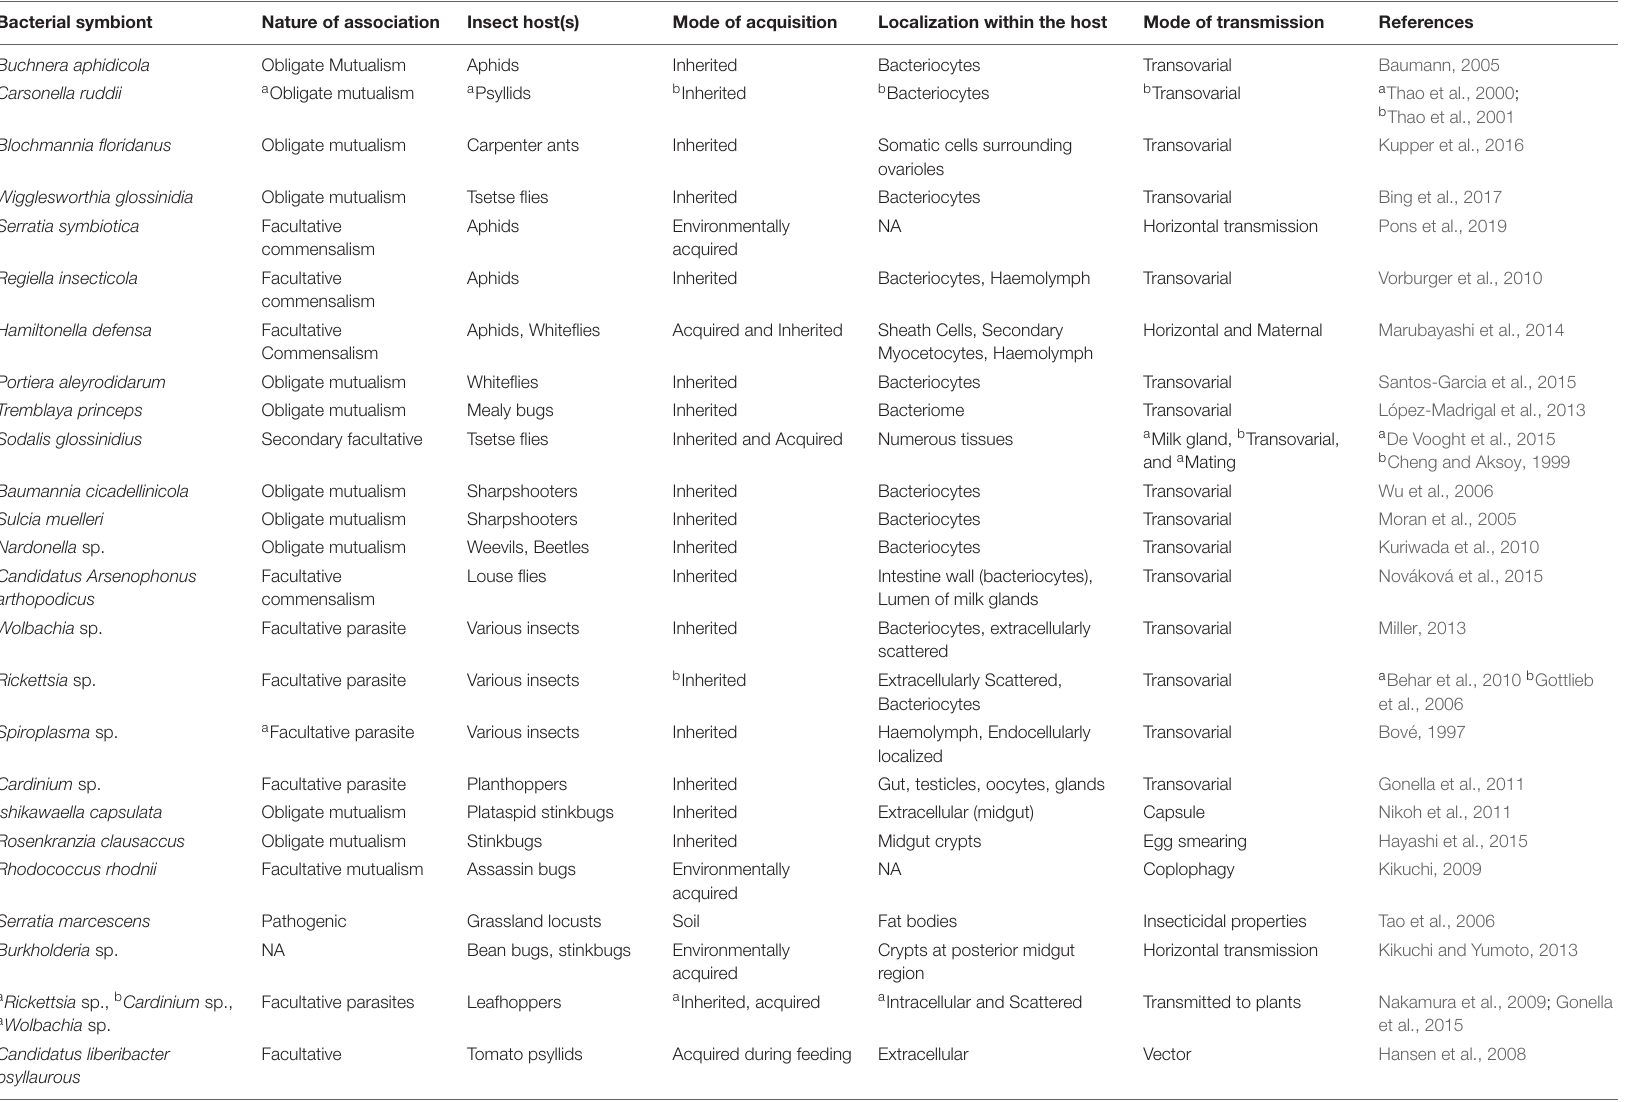
TABLE 2 | List* of bacterial species and type of their associations with insects; their known mode of acquisition, localization and transmission. Bacterial